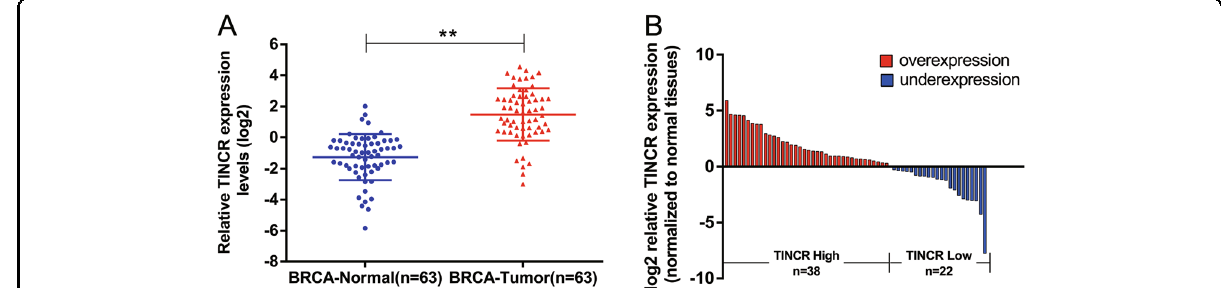
Fig. 1 The relative expression of TINCR in breast cancer tissues and its clinical signi fi cance. A Data from the TCGA database shows the relative expression of TINCR in 63 pairs of breast cancer and adjacent normal tissues. B The qRT-PCR experiment detected the relative expression of TINCR in 60 pairs of breast cancer tissues and their adjacent non-cancerous tissues. According to the level of TINCR expression, the tissues were divided into two groups: TINCR high expression group and TNCR low expression group. Error bars indicate mean ± standard errors of the mean. The mean values of two groups were compared via paired, two-tailed Student t tests. * P < 0.05, ** P <